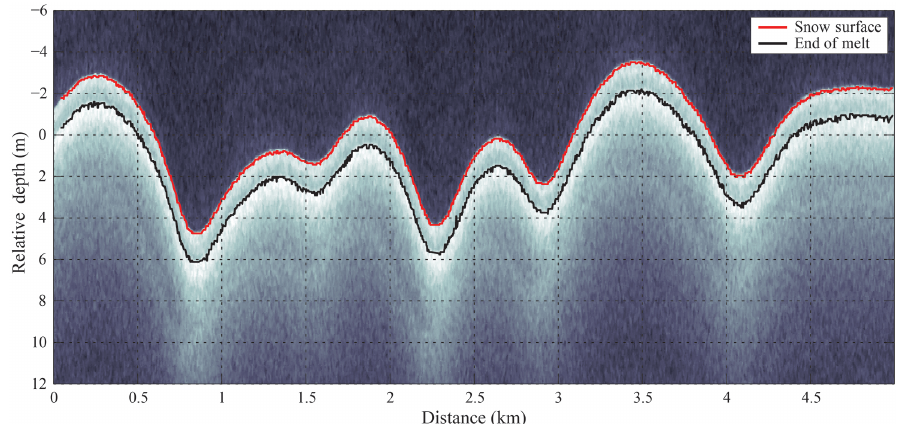
Figure 2. Sample radar echogram obtained from CReSIS Ku-band radar (14–16GHz) on board the 16 November 2009 Operation IceBridge flight. Automated surface and subsurface picks are overlaid. Darkest colours indicate air above the snow surface. On the vertical axis, we show the vertical direction relative to an arbitrary level. Nearly all echograms look similar, with very strong surface and a strong to very strong subsurface reflection horizon. The subsurface horizon is interpreted as the end of the last melt season, and it physically represents the transition from dry snow (above) and snow that has strong melt features (ice lenses).